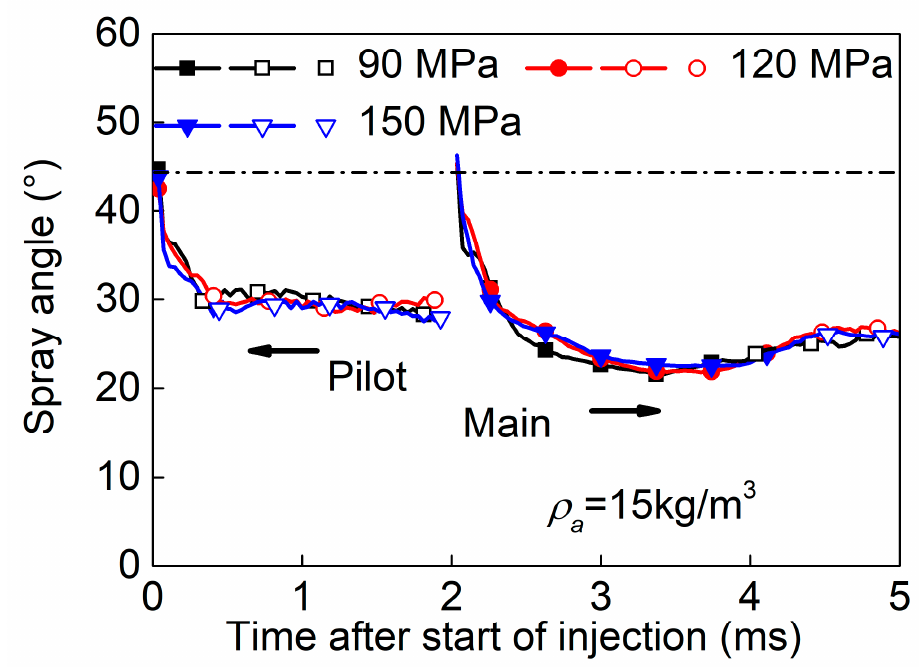
Figure 10. The spray angle evolvements when applying the pilot-main injection strategy under various injection pressures.